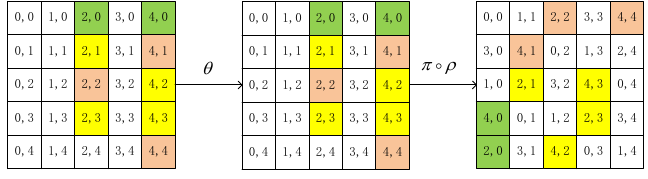
Figure 17: Attack on 7-round Ketje Sr